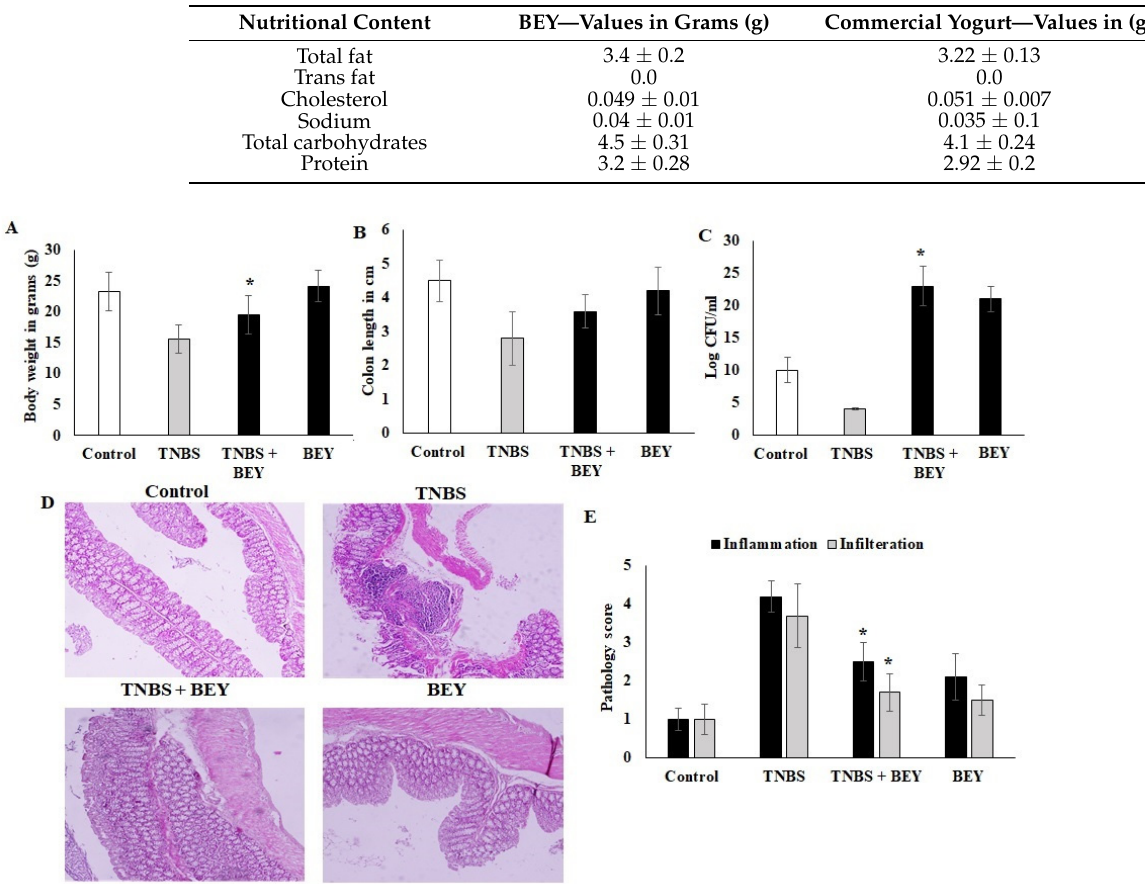
Table 2. Nutritional content of BEY (~100 mL) in comparison with commercial yogurt.